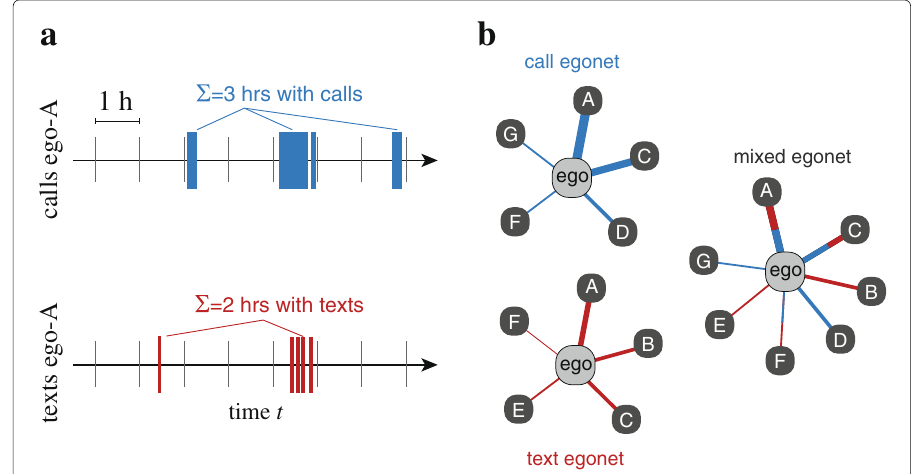
Fig. 1 Constructing Egocentric Networks. Constructing egocentric networks from calls and texts using time-binned weights. a The timelines corresponding to each of the ego’s alters are divided into bins–we use bins that span one hour. Then, the number of bins with at least one communication event is computed. These numbers are used as link weights for egocentric networks (panel b ). For the mixed networks, the link weights represent the number of bins where either calls, texts, or both are taking place